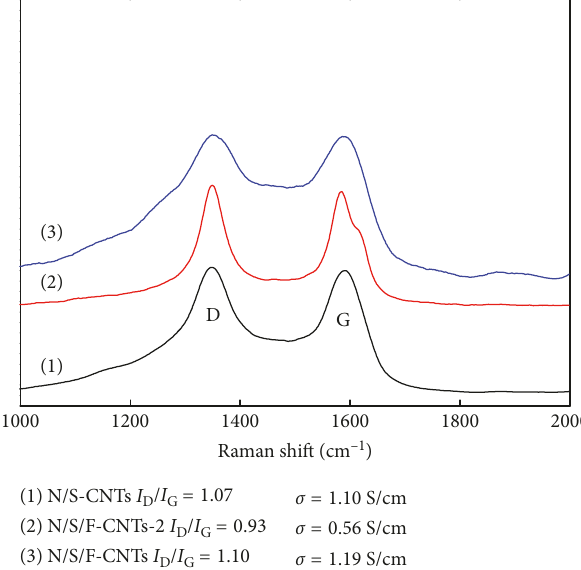
Figure 1: Raman spectra of the catalysts.